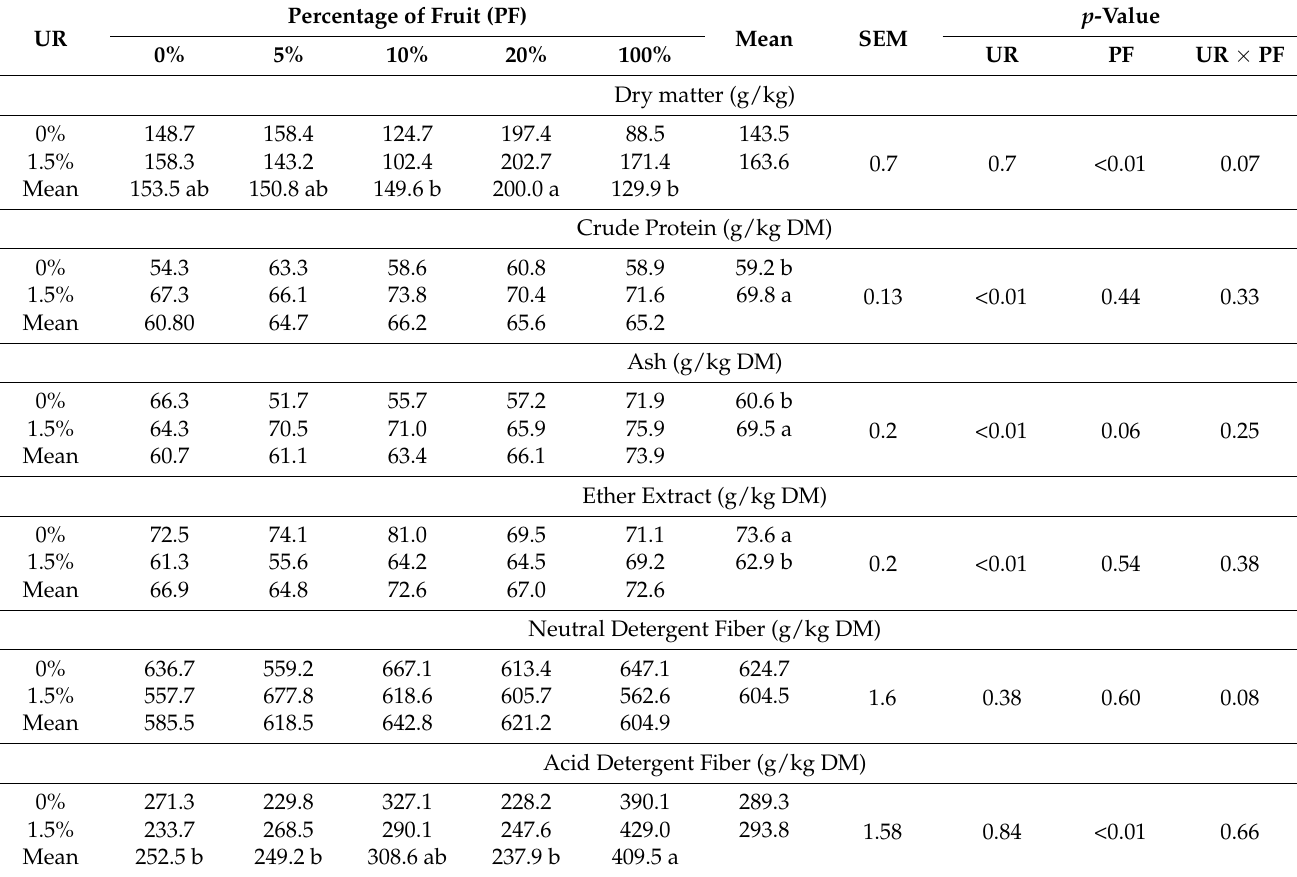
Table 3. Chemical composition and pH of silages with different mixtures of melon biomass and addition of